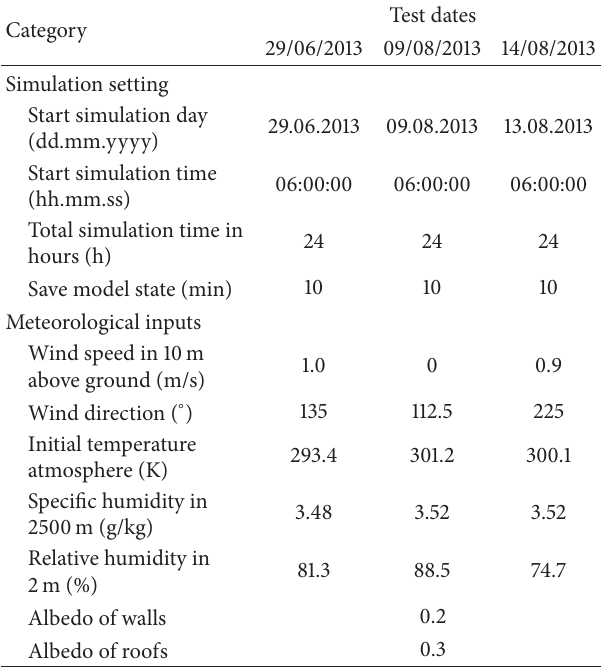
Table 2: ENVI-met model configuration-file